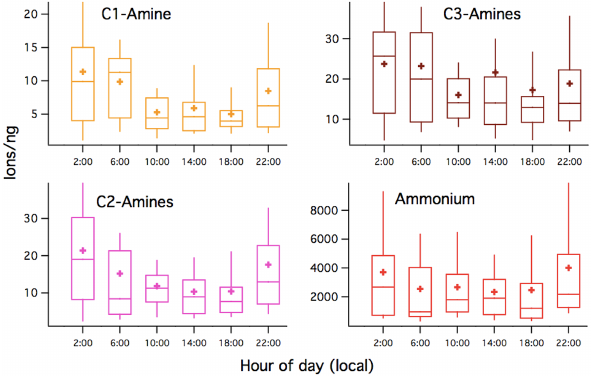
Figure 5. Campaign-averaged, 4-hour-binned C1- to C3-amines and ammonium particle-phase signals from TDCIMS. Line end- points are the 10th and 90th percentile, bottom and top of the box indicates 25th and 75th percentile, horizontal lines are the median and the crosses are the mean. The ion data used were background- corrected, detectable (2-sigma) points from 30min particle collec- tions and are mass-normalized by the collected particle mass. Col- lected particle masses ranged from 2–80ng, and volume mean di- ameters for collected particles ranged from 40–120nm.